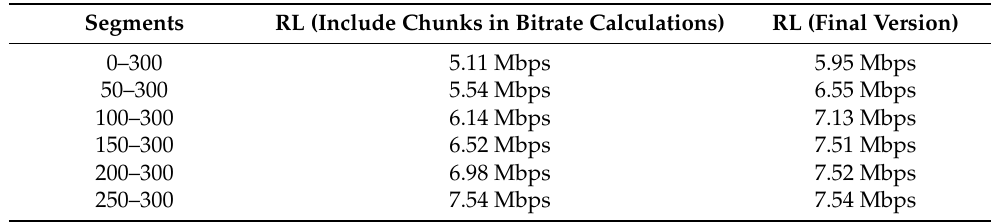
Table 3. Average video bitrate for the proposed scheduler. The left column is the result of the reinforcement learning scheduler without any modifications. The right column is the result of applying the correction for the underestimation of the